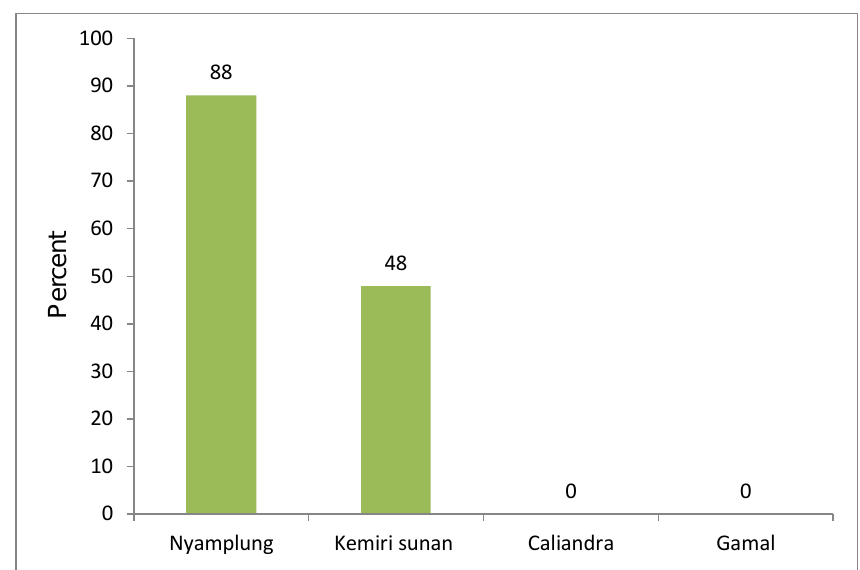
Figure 4. Survival rate of the four selected bioenergy species in Buntoi research site in Pulang Pisau, Central Kalimantan.